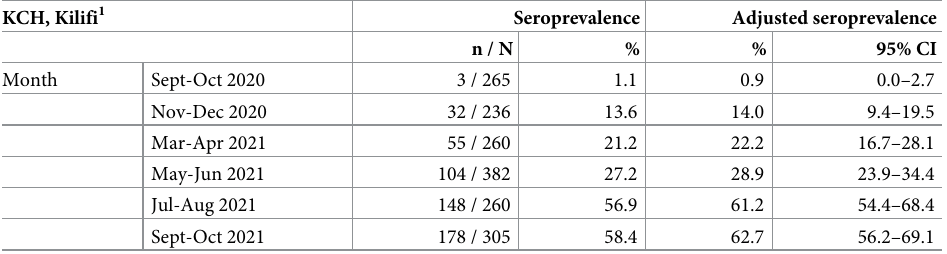
Table 3. Seroprevalence of IgG to SARS-CoV-2 among mothers attending antenatal care in Kilifi County Hospital (KCH), over